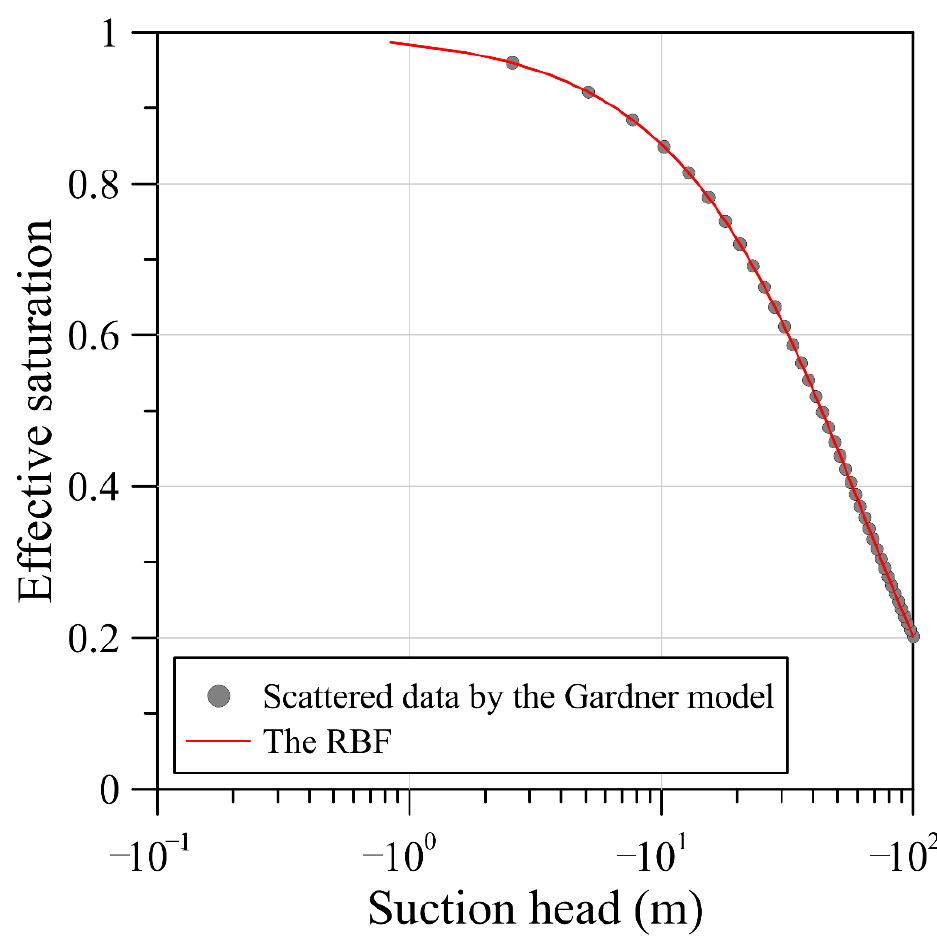
Figure 9. Comparing effective saturation using RBF with scattered data by the Gardner model.